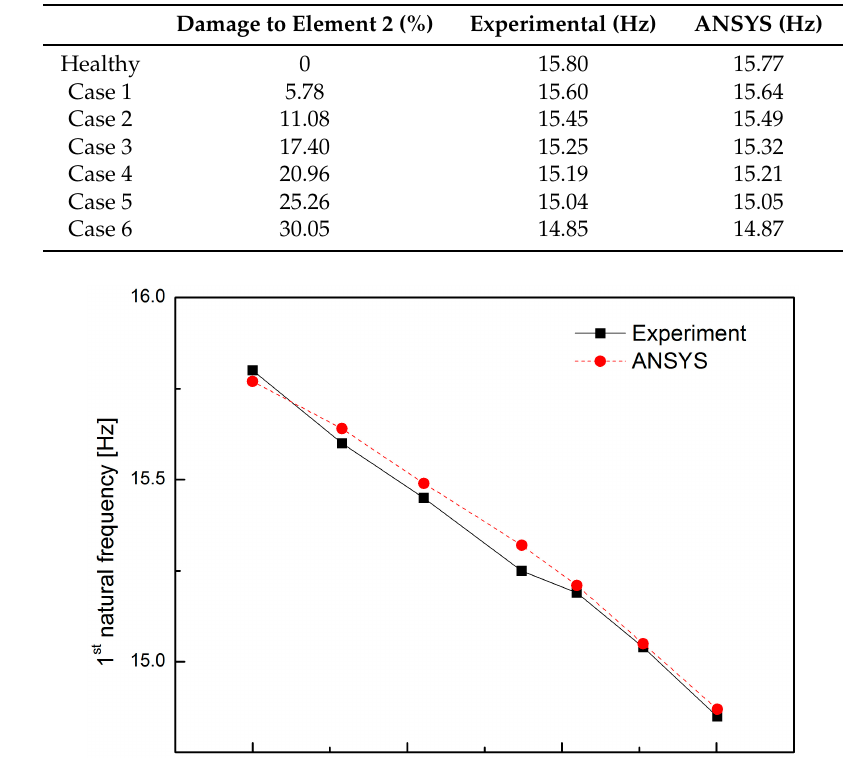
Table 3. First natural frequencies for various damage cases of Element 2 of the cantilever beam.